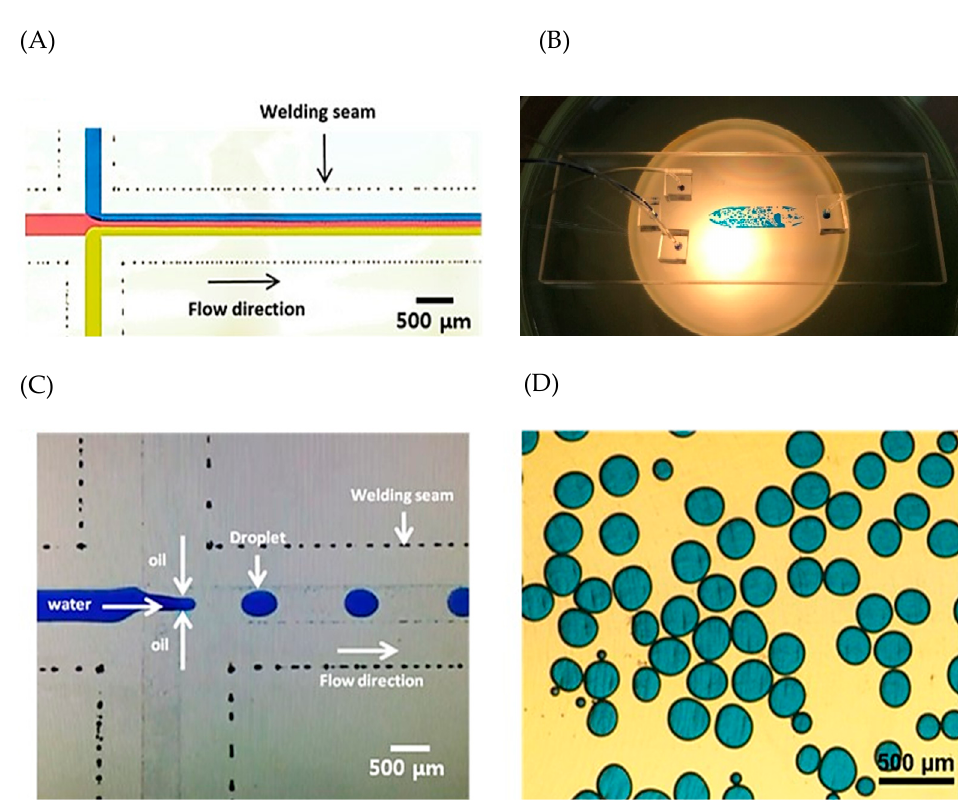
Figure 7. ( A ) Picture of the laminar flow generated at the microfluidic channel fabricated by laser test. ( B ) Picture of the fabricated droplet generator. ( C ) Picture of droplet generating at the cross-section. Blue dye was mixed with water to show the droplets clearly. ( D ) Generated droplets collected at a reservoir.